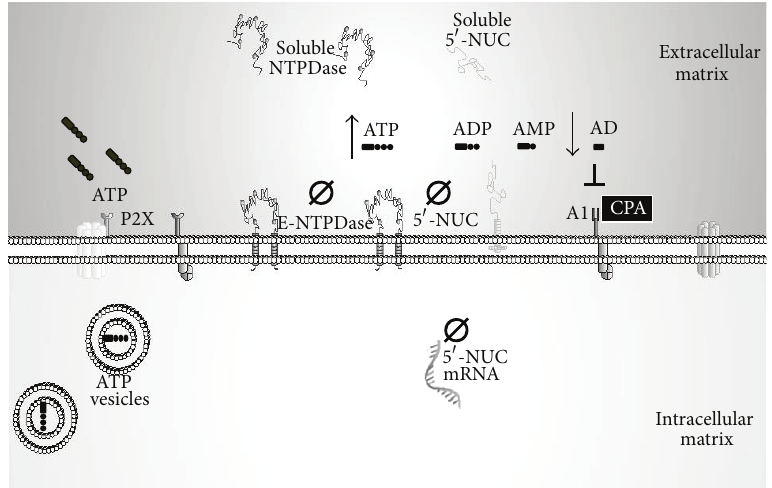
Figure1:SchematicfigurerepresentingourdatarelatingthepurinergicsystemwithhyperthyroidismintheCNS.Thefiguredemonstratesthat the induction of hyperthyroidism resulted in a significant reduction in the NTPDases and 5 󸀠 -nucleotidase (5 󸀠 -NUC) activities which degrade the ATP to adenosine in the brain rats chronically treated with T4 [55]. This result was also observed in 5 󸀠 -nucleotidase expression in brain of hyperthyroid rats [57]. This leads to an increase of ATP availability as an excitatory neurotransmitter and the reduction of adenosine as an inhibitory neuromodulator in different brain fractions studied. The reduction in the extracellular adenosine levels may reduce the inhibitory effects mediated by adenosine A1 receptors. This relation was demonstrated in hyperthyroidism, once that N6-cyclopentyladenosine (CPA), a selective agonist of the A1 adenosine receptor, reverted the hyperalgesia induced by hyperthyroidism and increased the total antioxidant reactivity in hyperthyroid brain [58]. Moreover, the effects observed in the nervous system were also observed in blood serum of hyperthyroid rats, indicating a possible use of soluble enzyme markers for this thyroid disease [55,